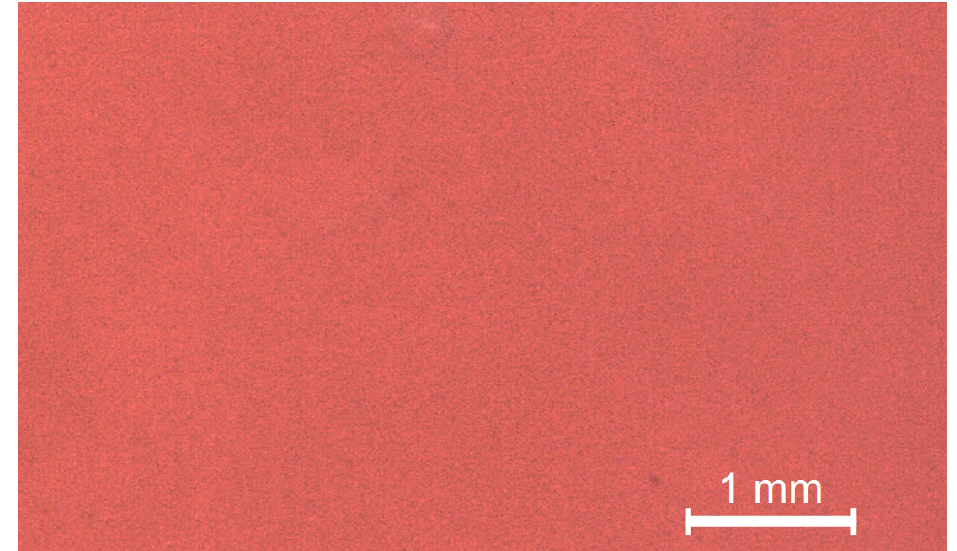
Figure 4. Resin fracture surface observation in stereomicroscopy (Leica ® M125 C). It shows fracture lines on a uniform surface.